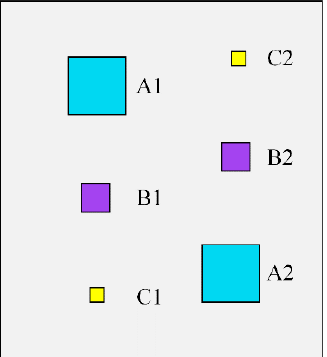
Figure 5. Illustration of defective regions in a CFRP specimen 2.